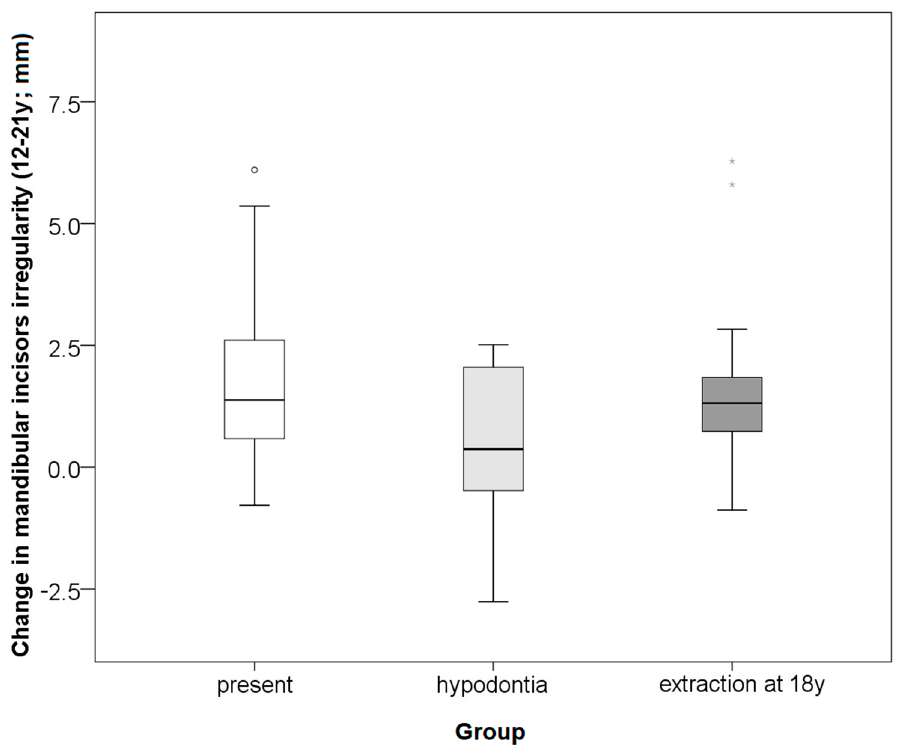
Figure 4. Comparison of change in mandibular incisor irregularity (The irregularity index) from 12 to 21 years between the groups with present, absent and extracted third molars. Circles and asterisk present outliers and extremes. Table 2. Comparison of the change of the Little’s irregularity index in the period 12–21 years between the groups with present, hypodontia and extracted third